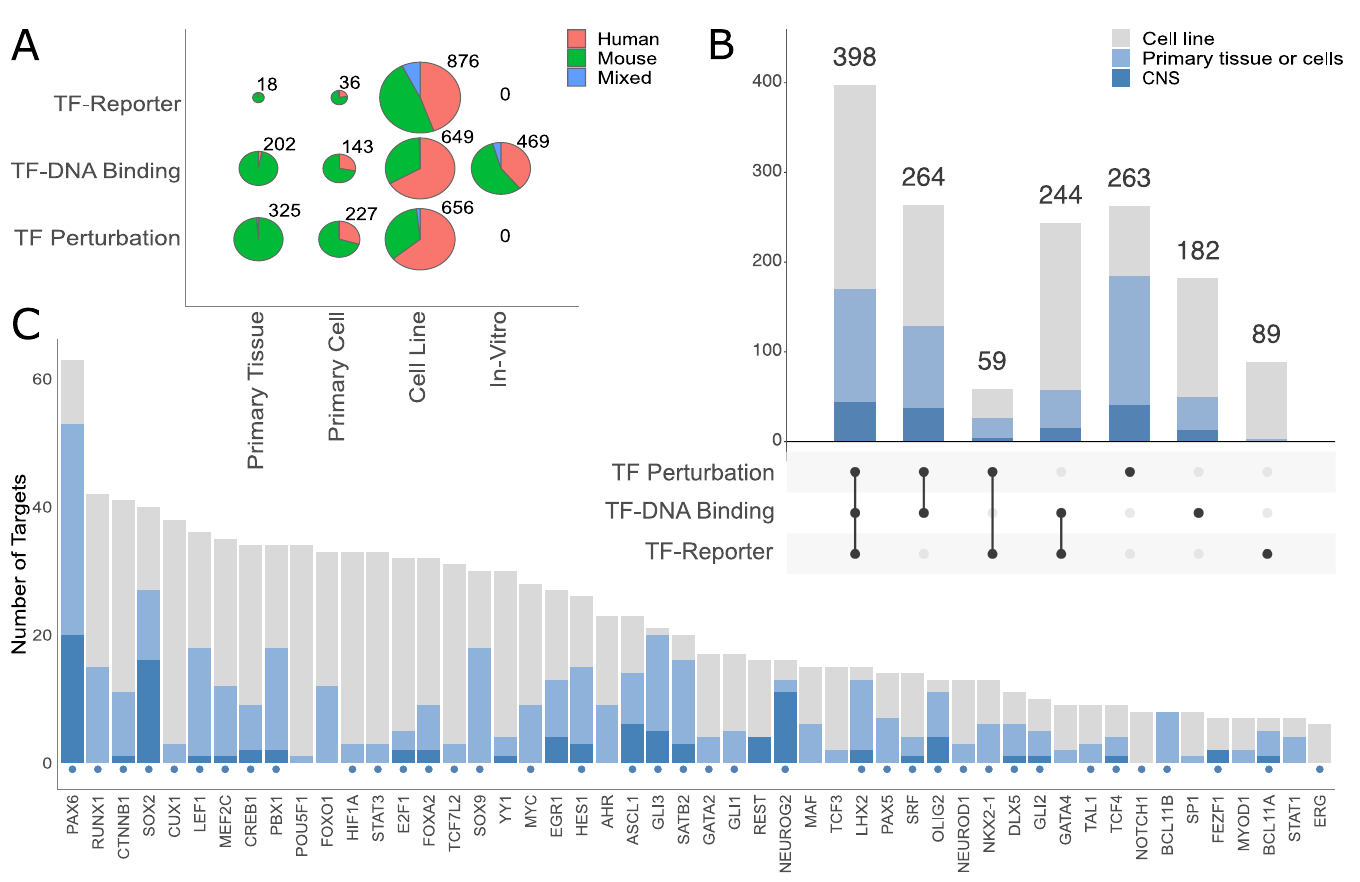
Fig 3. Summary of recorded DTRIs. (A) Breakdown of recorded experiments across experiment types and context types. The “in-vitro” category only includes EMSA experiments for testing TF-DNA binding. (B) Breakdown of DTRIs across different combinations of experiment types. Colors correspond to cellular contexts indicated in the color legend. (C) Number of targets per TF for the top 50 TFs. Color coding is the same as in (B). Neurodevelopmental TFs are indicated by blue circles. There are 39 TFs with more than ten targets (denoted by the horizontal dotted line).